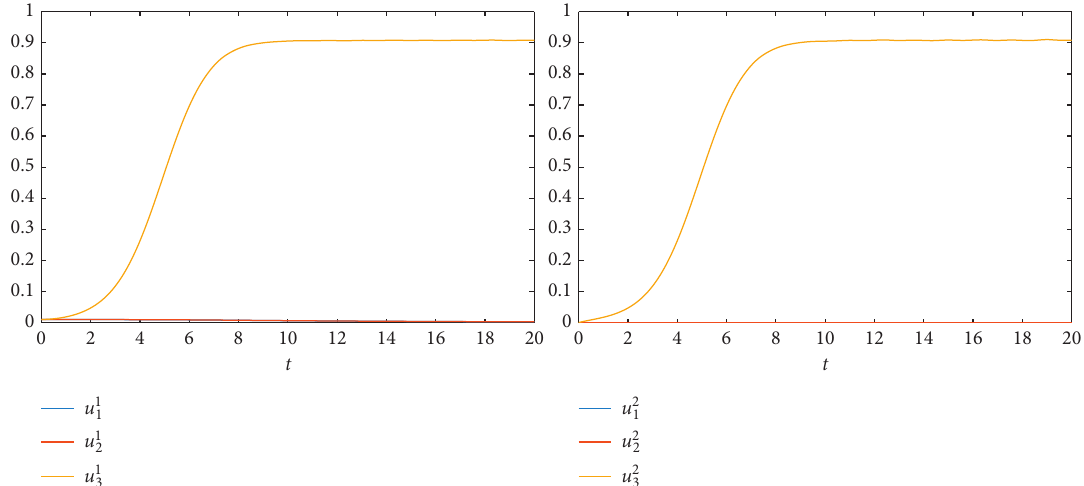
Figure 3: Simulation of (43) with (40) by fixing ( d